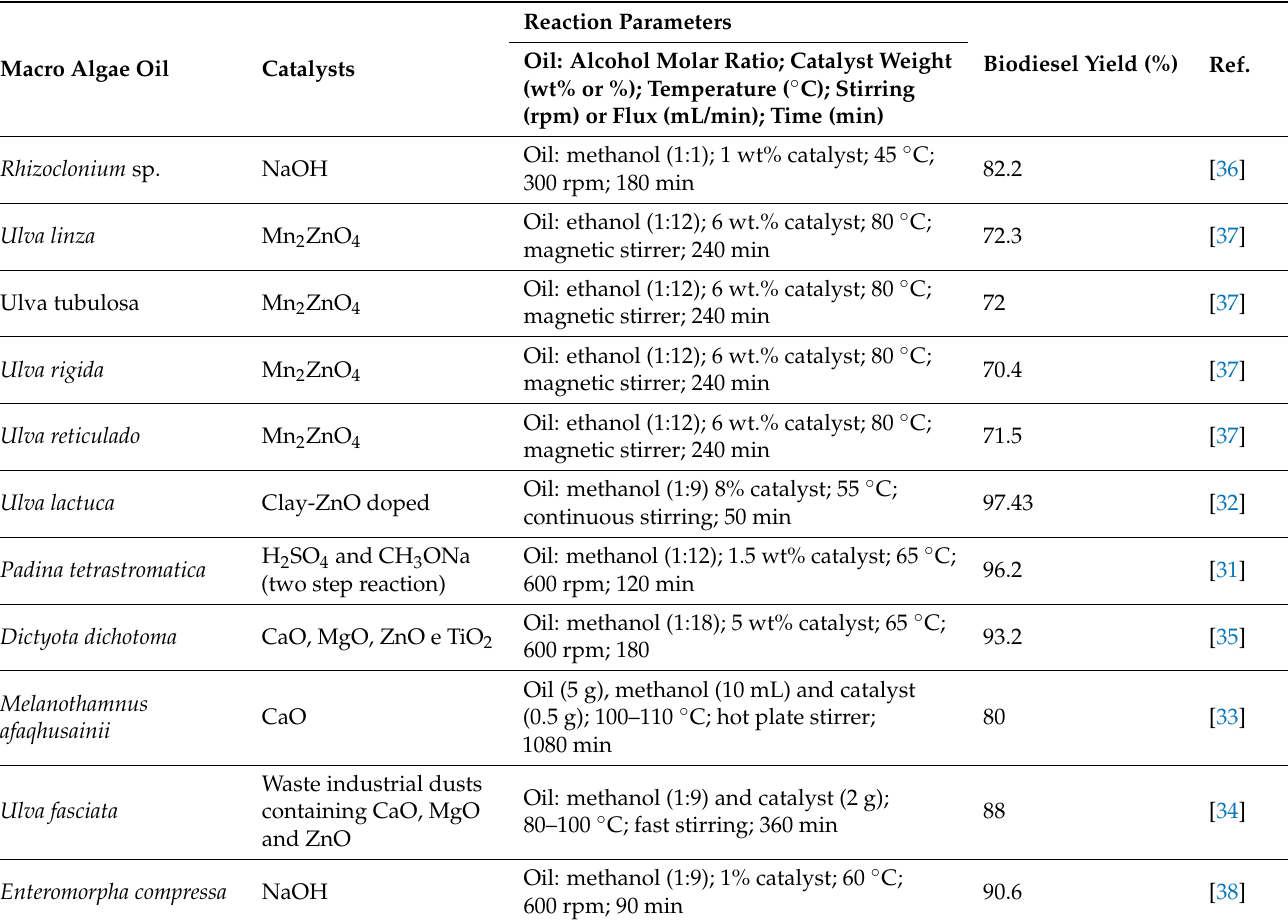
Table 2. Biodiesel production from macroalgae oil as feedstock by heterogeneous